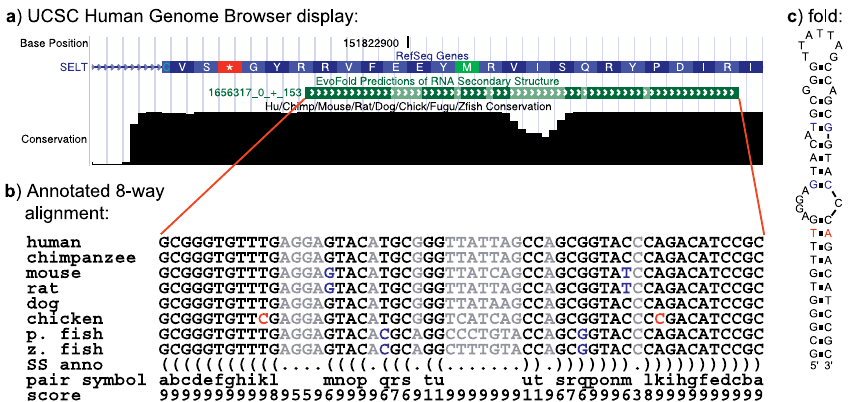
Figure 3. Coding Hairpin near Selenocysteine Insertion Site (A) Gene structure, EvoFold predictions, and conservation around the selenocysteine insertion site of selenoprotein T (SELT). The pairing regions of the hairpin are shown in dark green and can be seen to start only eight bases downstream of the UGA insertion site (indicated by *). Arrows indicate direction of transcription. (B) Annotated segment of eight-way alignment spanning the predicted hairpin. SS anno, secondary-structure annotation in parenthesis format (matching parentheses indicate pairs and periods indicate unpaired regions); pair symbol, pairing columns are assigned identical symbols to facilitate navigation; Score, position-specific scores (0–9), which indicate confidence in secondary-structure annotation. Substitutions in predicted pairs are color- coded relative to the human sequence: green is a compensatory double substitution, blue is a compatible single substitution, and red is a noncompatible substitution. (C) Depiction of hairpin, which is shown with T instead of U to facilitate comparison with the genomic sequences. Pairs are color-coded by presence of substitutions in the eight-way alignment (see b). DOI: 10.1371/journal.pcbi.0020033.g003